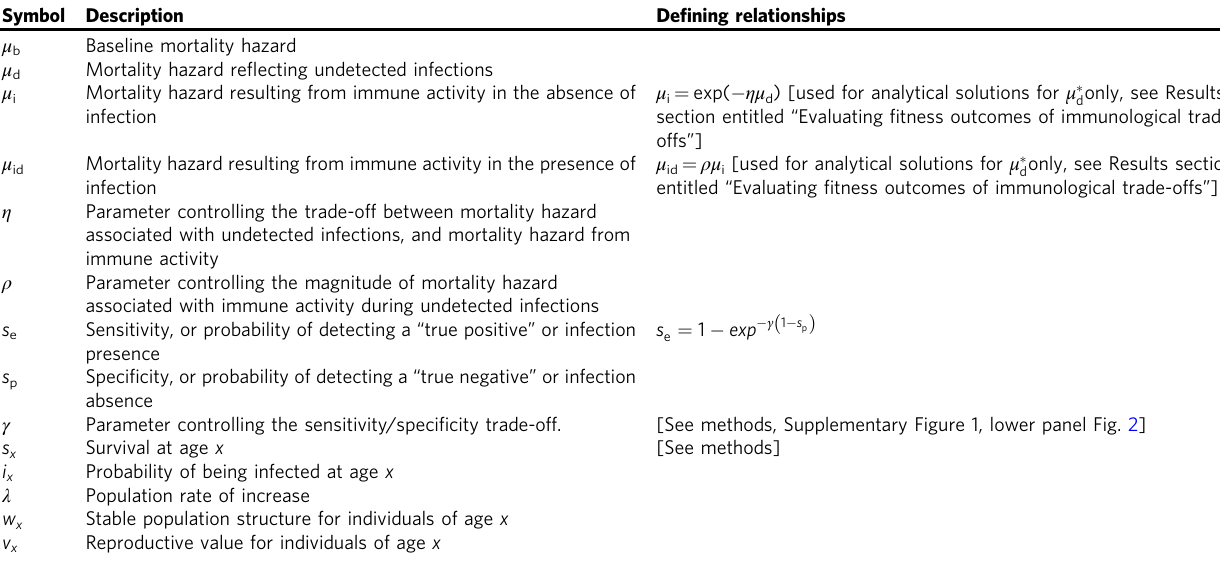
Table 1 Model parameters, description, and, where appropriate, de fi ning relationships characterizing the core trade-offs